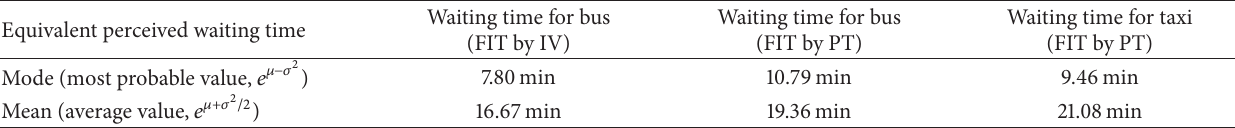
Table 6: Characteristics of equivalent perceived waiting